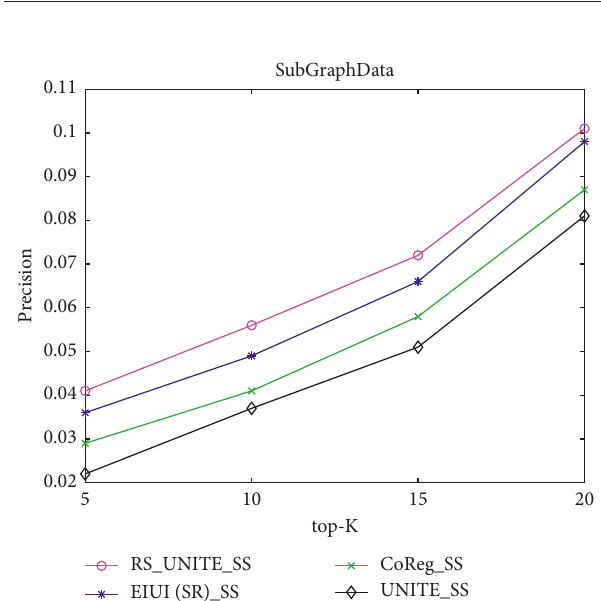
Figure 2: Comparison of methods based on user interest behavior prediction accuracy on SubGraphData.